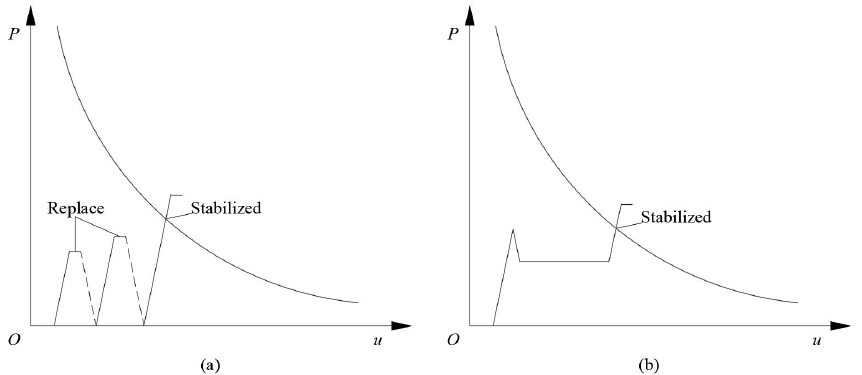
Figure 1. Support characteristic curve and surrounding rock characteristic curve: ( a ) traditional sup- port; ( b ) energy-absorbing